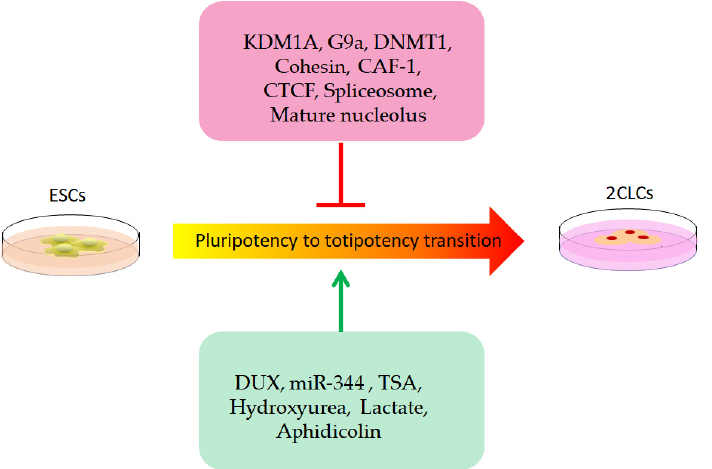
Figure 2. Schematic figure summarizing factors that promote or inhibit the transition from ESCs to 2CLCs. On the one hand, inhibitors, such as KDM1A, G9a, DNMT1, cohesin, CAF-1, CTCF, spliceosome and mature nucleolus, impede 2CLCs formation; on the other hand, some cellular active small molecule or chemicals, such as DUX, miR-344, TSA, hydroxyurea, lactate and aphidicolin, drive pluripotency to totipotency transition and facilitate 2CLCs